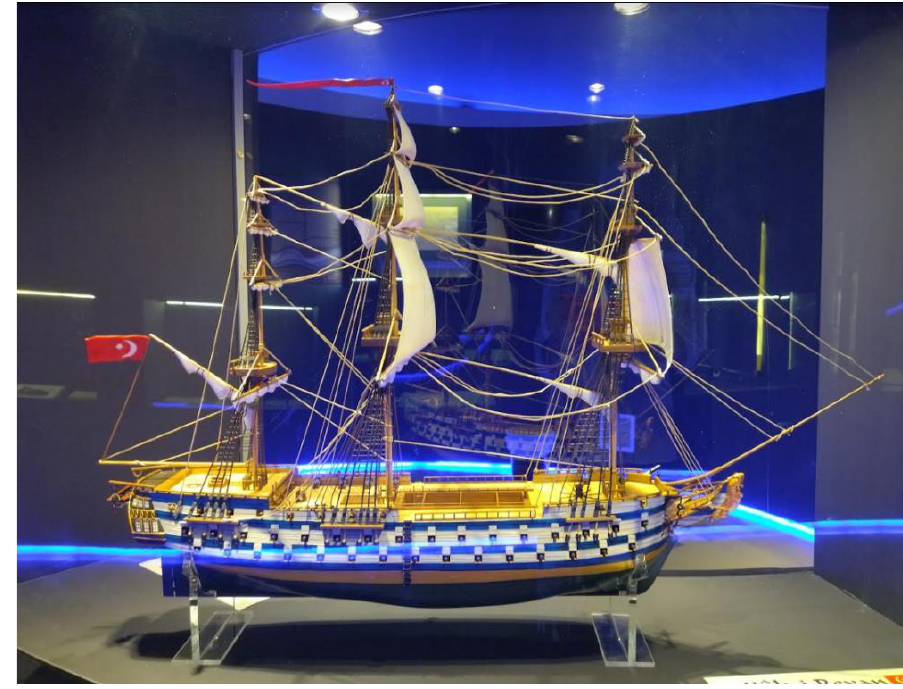
Figure 25 . Kuh I Revan 3D-printed model after painting process.